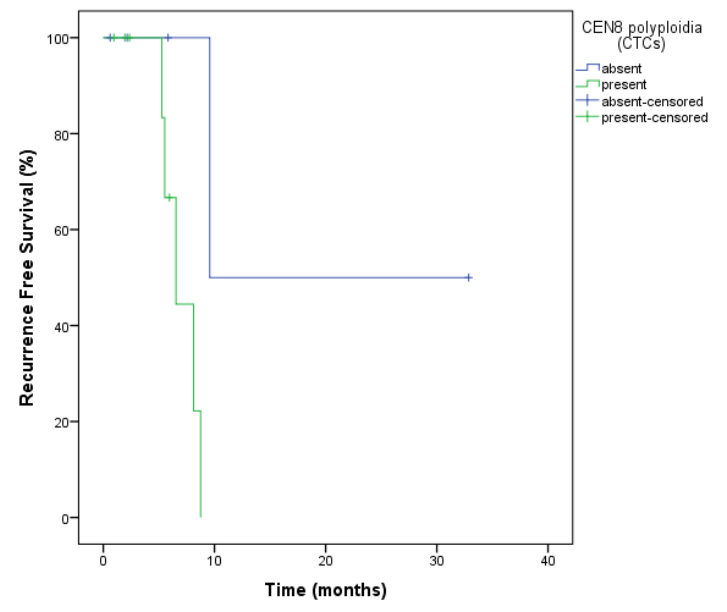
Figure 2. Recurrence-free survival analysis of ovarian cancer patients for CEN8 expression in CTCs (hybrid cells) at the baseline. The presence of polyploidy in the CEN8 showed a worse RFS (7.0 months vs. 21.21 months, p = 0.035) in relation to those who did not.